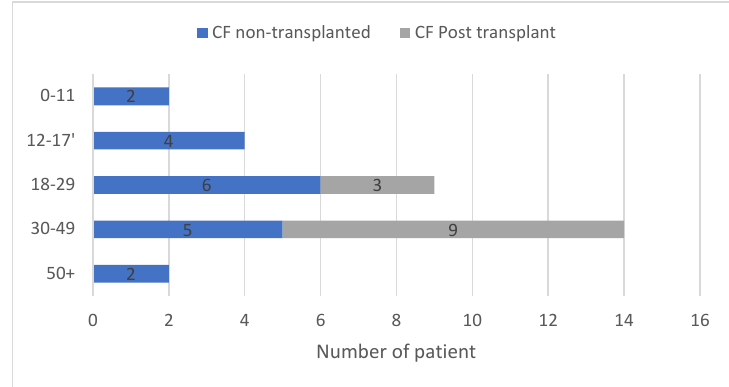
Figure 1. Distribution of the patients with cystic fibrosis at SARS-CoV-2 infection onset according to age-categories. Among the 31 included patients, a majority were adults ( ≥ 18 years) with 14 patients (45%) aged between 30 – 49 years-old, and 9 (29%) between 18 – 29 years-old. Only 6 patients (19%) were children.